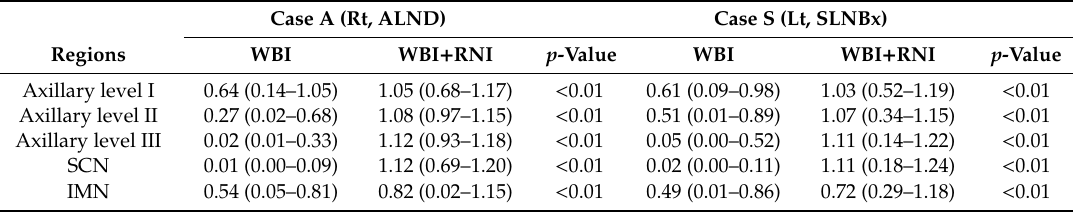
Table 2. Comparisons of relative mean nodal radiation dose between the treatment arms. Case A (Rt, ALND) Case S (Lt, SLNBx)